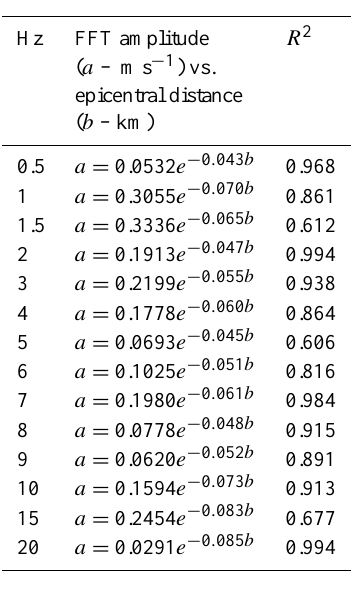
Table 4. Exponential correlation functions and related R 2 values referred to the FFT amplitude vs. epicentral distances derived from the accelerometric records of the 11 May 2011 mainshock of the Lorca seismic sequence.